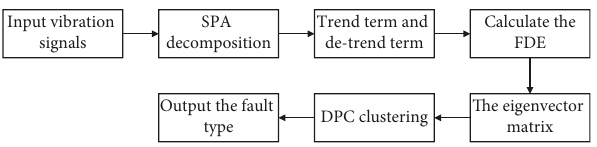
Figure 5: The flowchart of the fault diagnosis